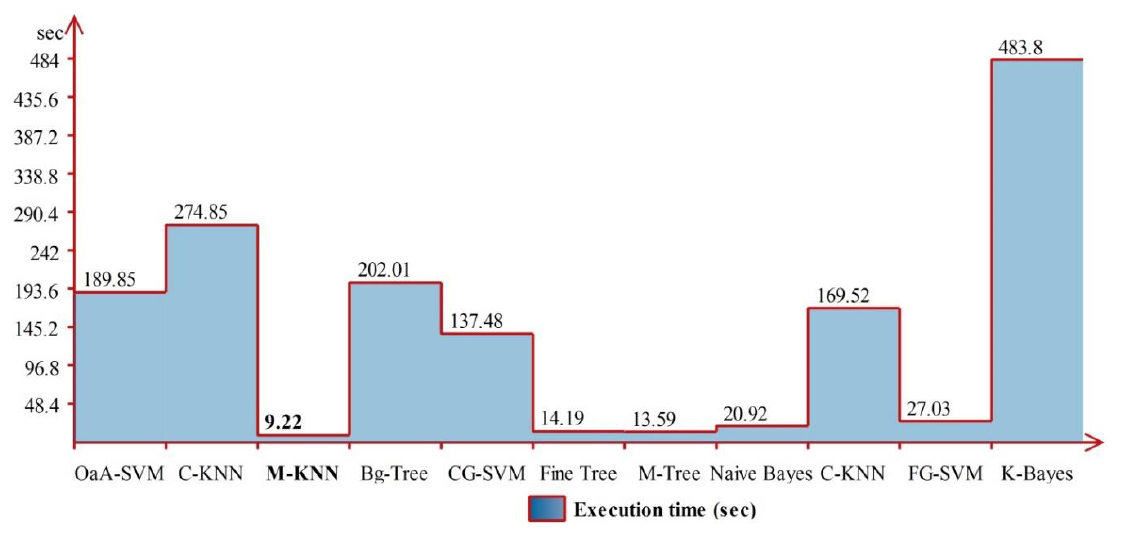
Figure 11. Variation in computational time for selected classifiers of 4 selected angles on Real time dataset.